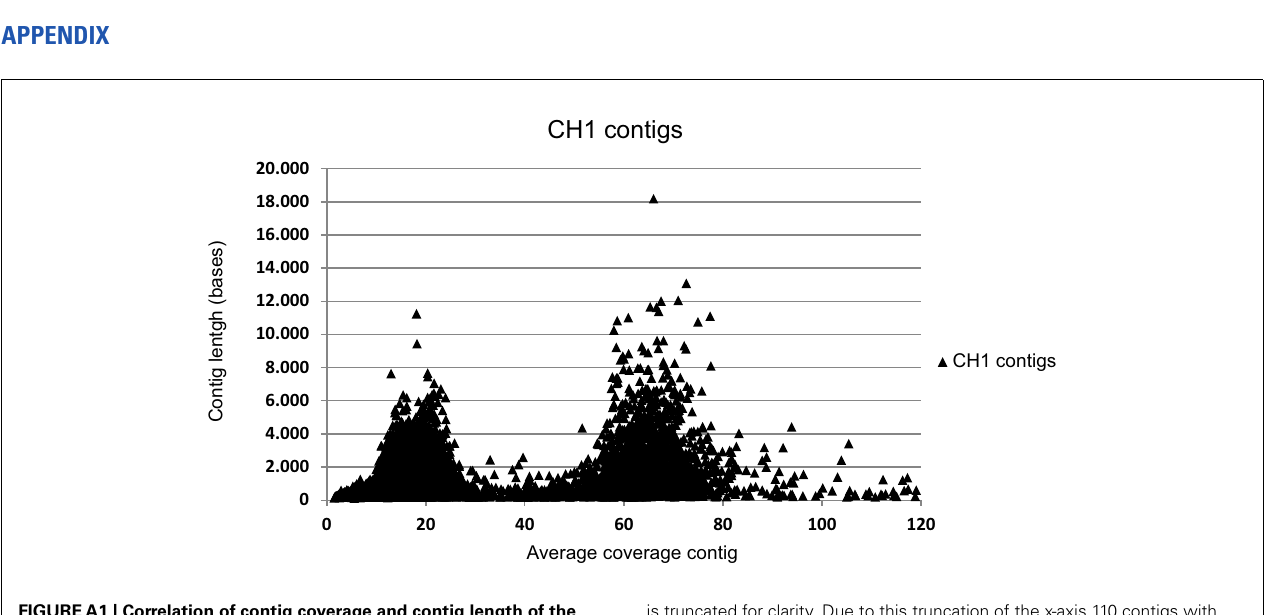
FIGUREA1 | Correlation of contig coverage and contig length of the 21,343 contigs of the CH1 assembly. Contigs with an average coverage of 37 or higher were selected for further analysis.The x -axis in this graph